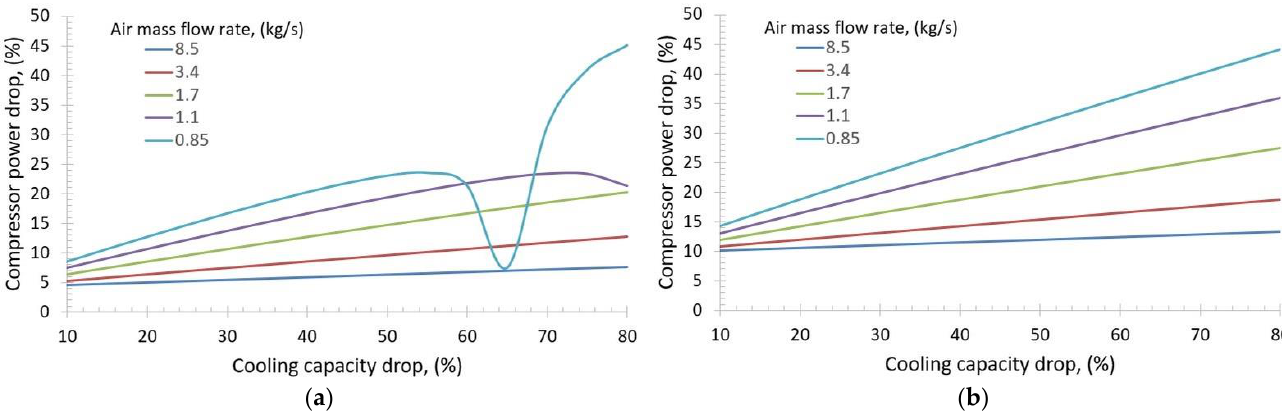
Figure 8. Relative compressor power drop in the function of cooling capacity drop for different air mass flow rates in: ( a ) Supercritical cycle; ( b ) Subcritical cycle.